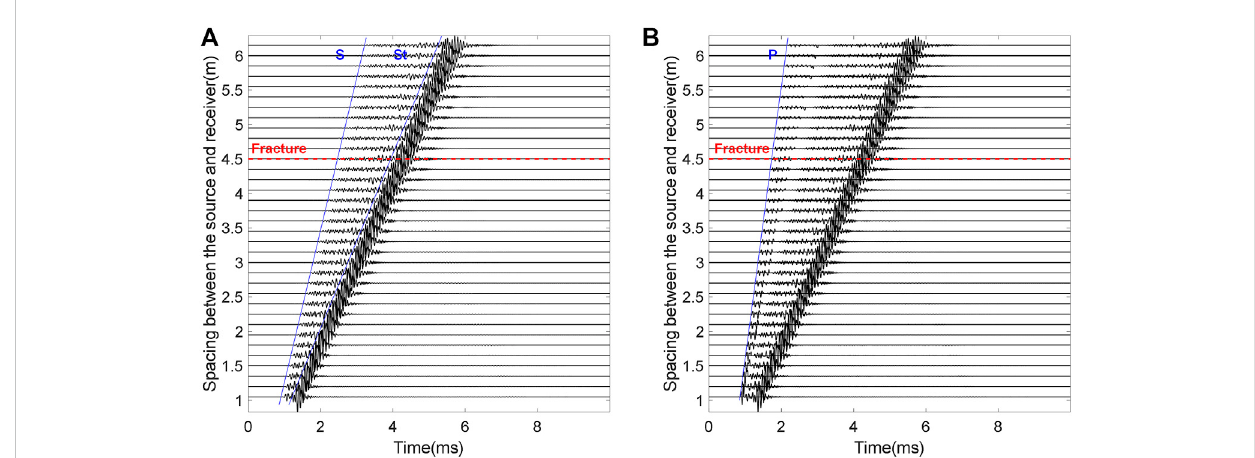
FIGURE 4 Monopole array waveforms. The red dotted line stands for the fracture center, which is 4.5 m away from the sound source. The fracture dip angle is 90 ° , the fracture width is 40 mm and fi lled with calcite. (A) Array waveforms (original); (B) Array waveforms (P wave is ampli fi ed by 200 times; S wave and Stoneley wave remain unchanged).